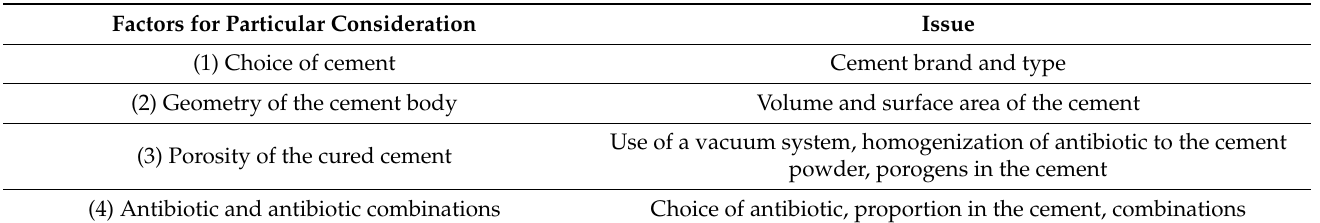
Table 1. Factors of antibiotic elution for particular consideration during clinical application and their